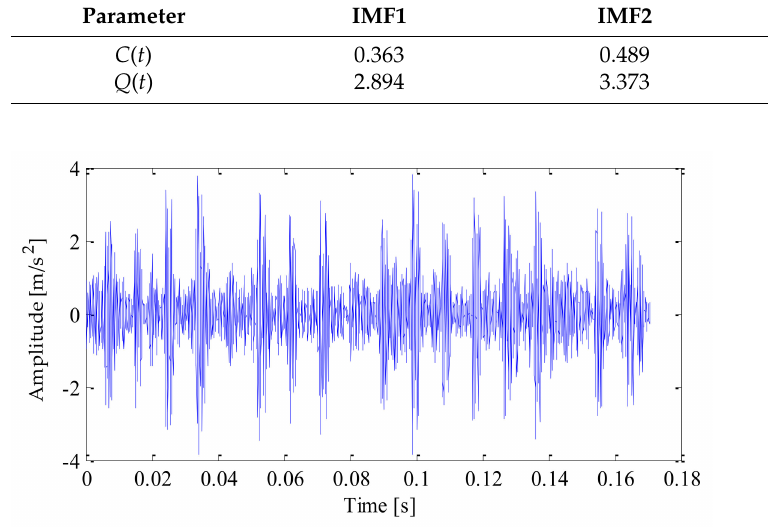
Figure 40. Noise-reduction results by the proposed